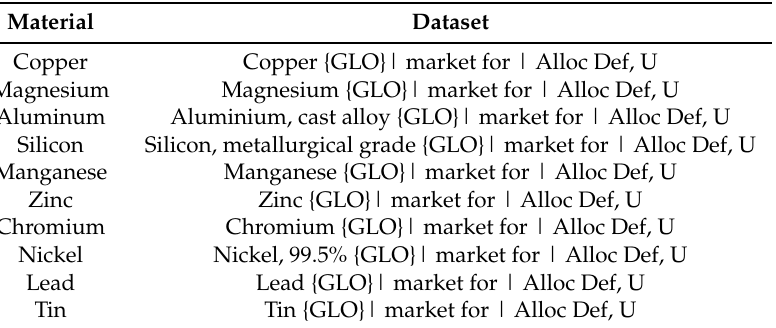
Table 6. EcoInvent dataset selection.